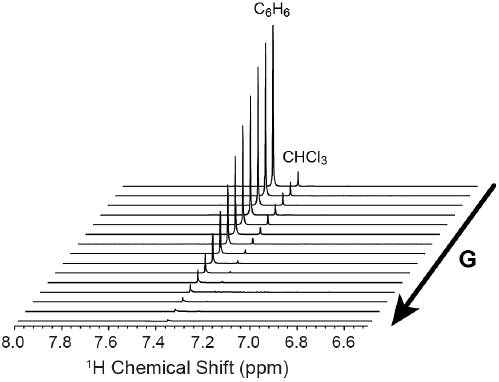
Figure 3. Stack plot of 1 H NMR spectra of benzene at with increasing gradient field strength (G).